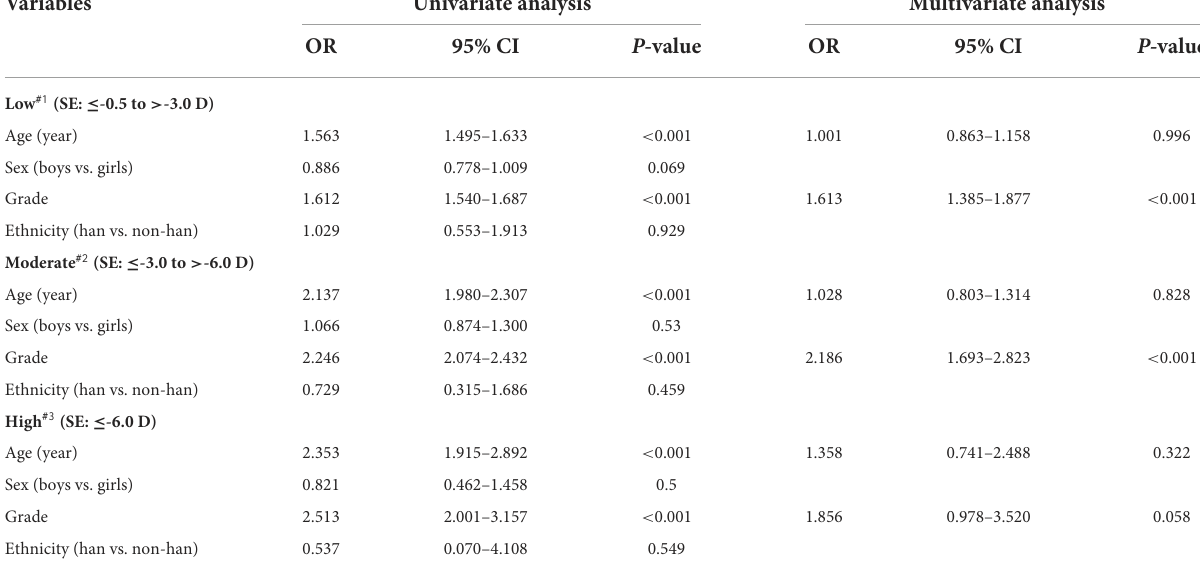
TABLE 4 Associations between the prevalence of different categories of myopia and associated factors. Variables